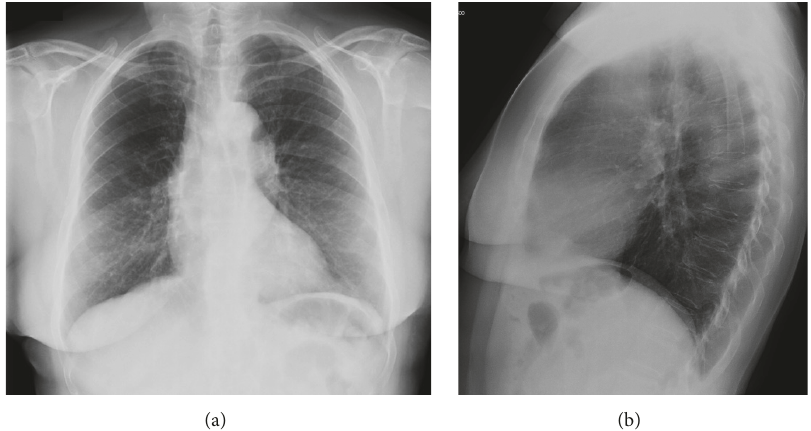
Figure 5: Posteroanterior (a) and lateral (b) chest X-rays. In a routine chest radiography 2 years before presentation in the ER it was difficult to detect the lesion in the left lower